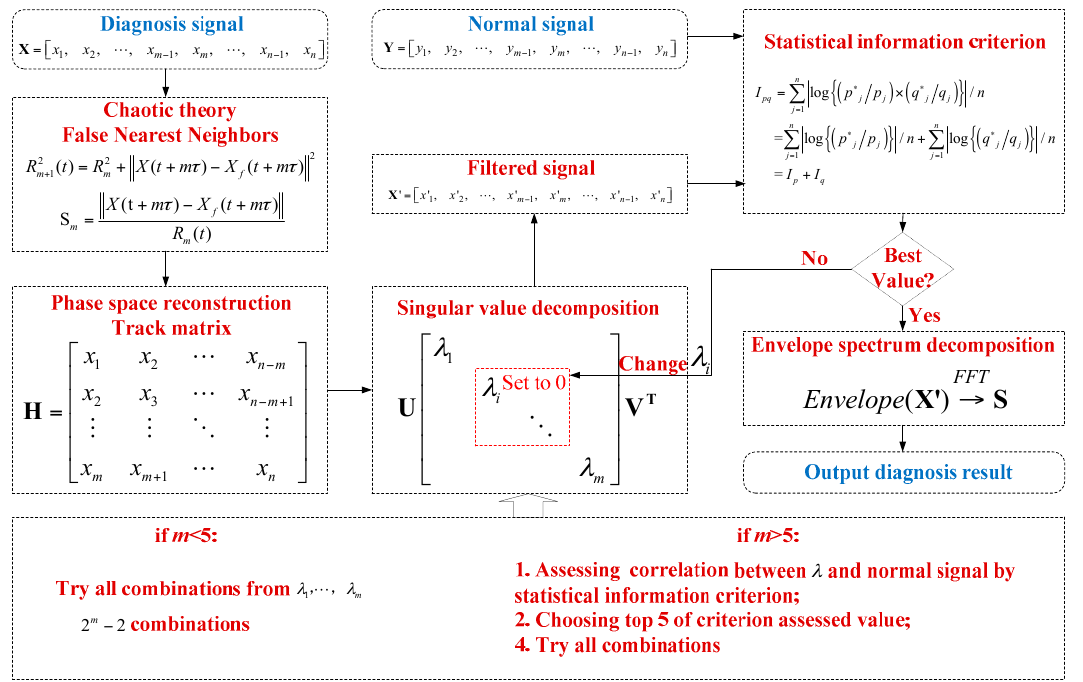
Figure 8. Flowchart of the proposed method.